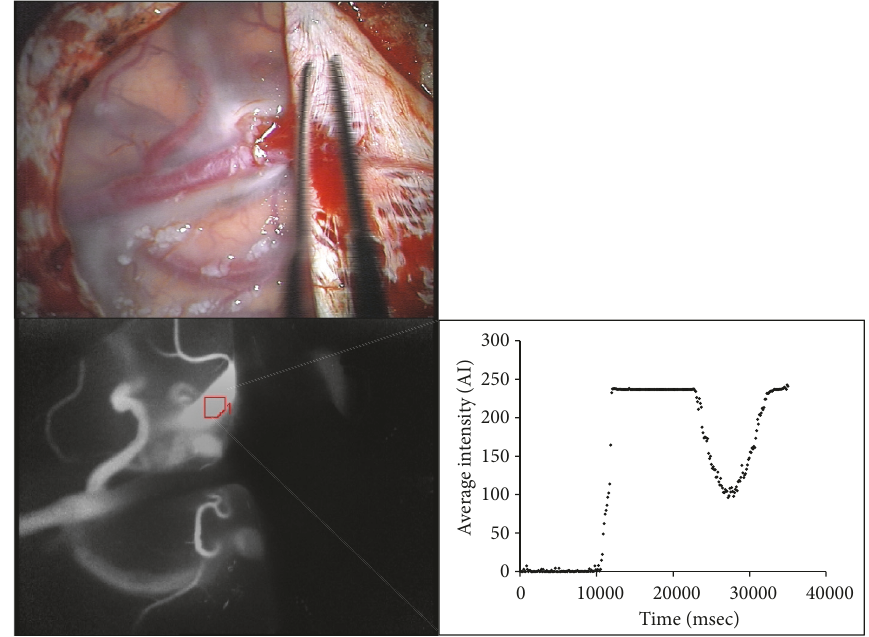
Figure 1: Example of ROI placement in an individual vessel of the AVM. Diagram showing the time-intensity curve of ICG in the individual vessel with ROI placement.